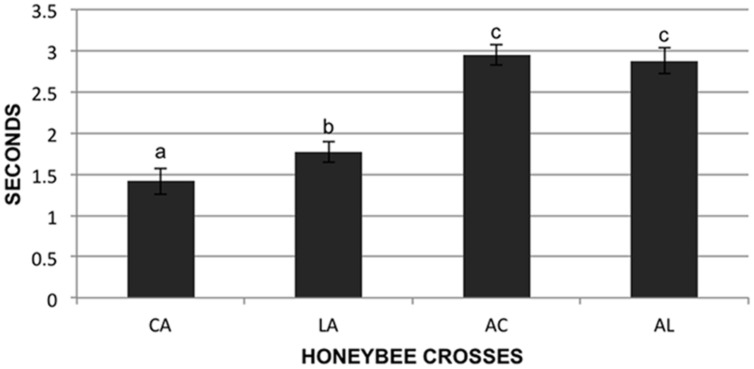
Sting response time of individuals. Individual bees (573 total) were given an electrical shock from a constant current stimulator and the time in seconds for them to sting a suede patch was recorded. Genotypes of reciprocal hybrids are given on the X-axis: Africanized maternity hybrids AC (Apis mellifera carnica father) and AL (A.m. ligustica father), and Africanized paternity hybrids CA (A.m. carnica mother) and LA (A.m. ligustica mother). Data presented is untransformed, letters designate significant differences.